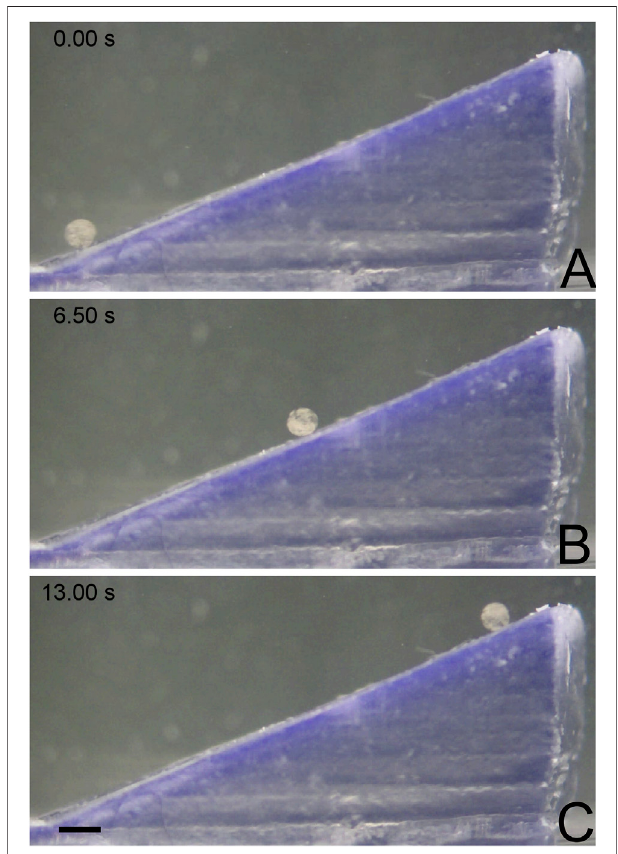
FIGURE 2 | MANiAC climbing up a 25 ° incline. (A) MANiAC (lower left) starts at the bottom of the incline and climbs (B) to the top (C) in 13 s. Scale bar is 0.5 mm. Video included in Supplementary Information